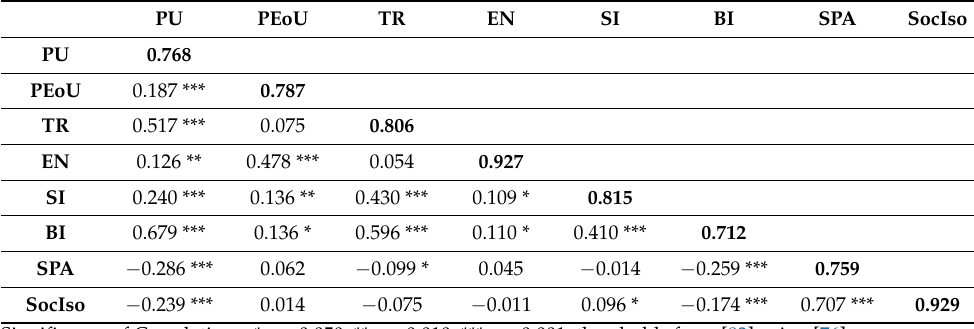
Table 8. Correlations of constructs.